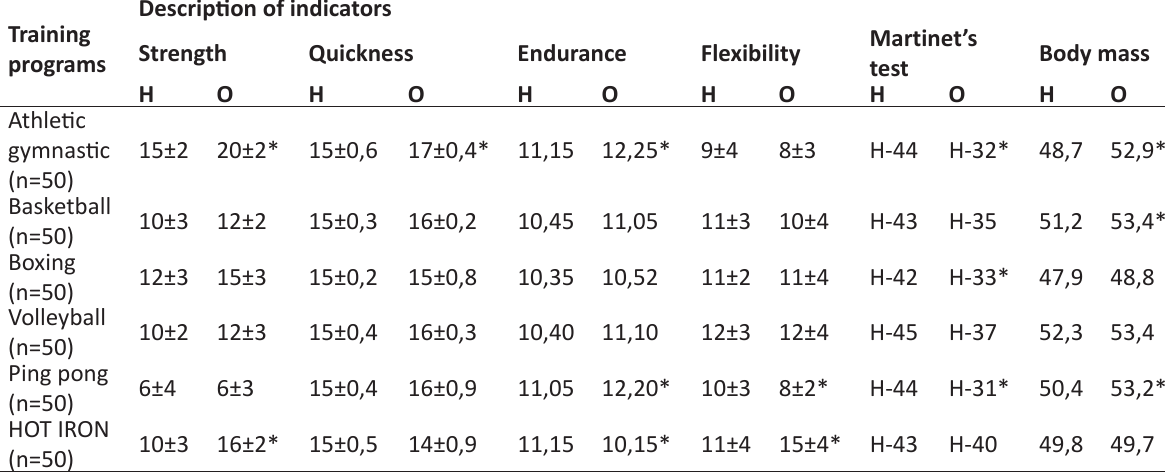
Table 2. Indicators of physical condition and functional fitness of the tested students (girls – n=300)